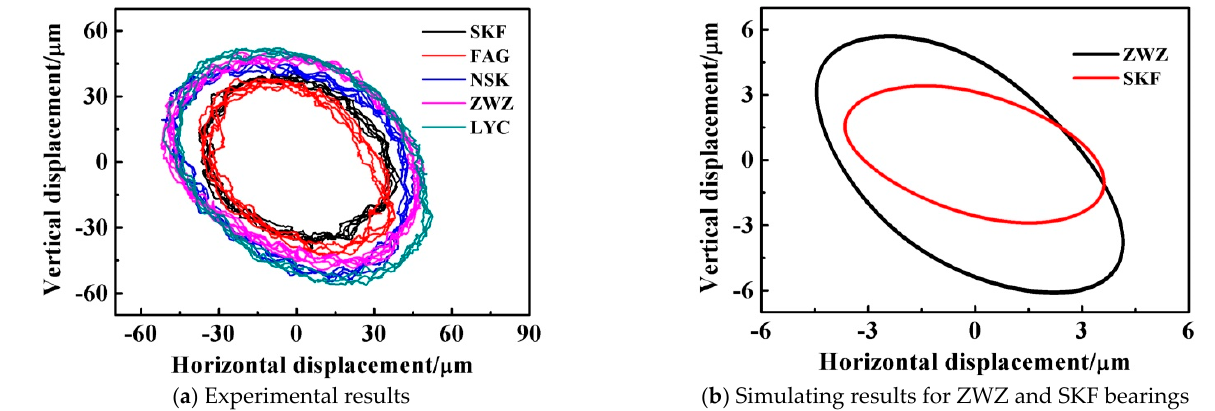
Figure 21. The motion orbits of SRBs with type 22215 from different manufacturers under adaptive self ‐ aligning operating conditions.